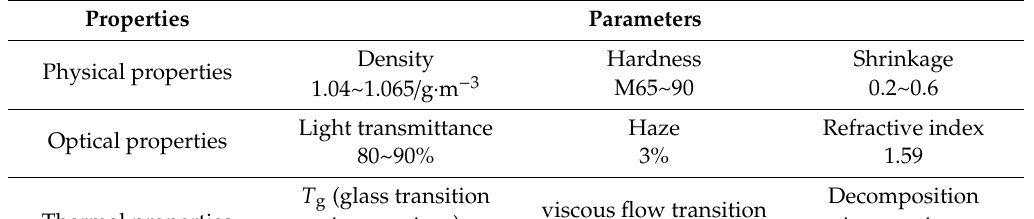
Table 1. PS properties parameters.